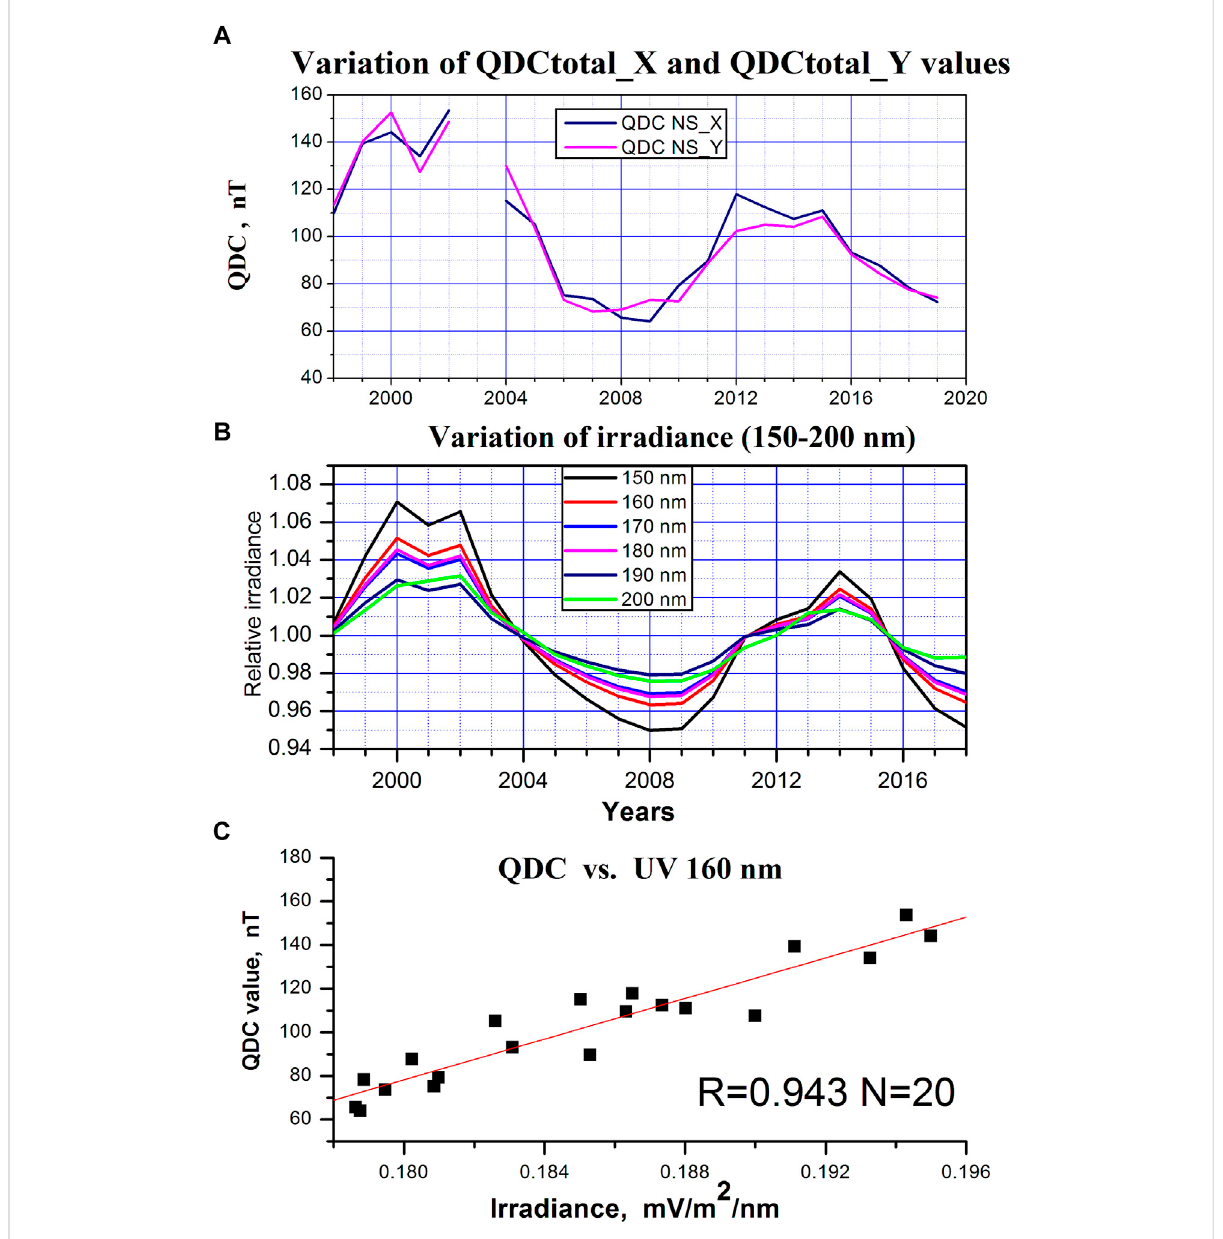
FIGURE 5 Run of yearly values of QDCtotal_X, QDCtotal_X (A) and solar UV (150 – 200 nm) irradiation (B) during 1998 – 2018 and correlation between the corresponding yearly values of UV(160 nm) and QDCtotal (C) (Troshichev et al.,